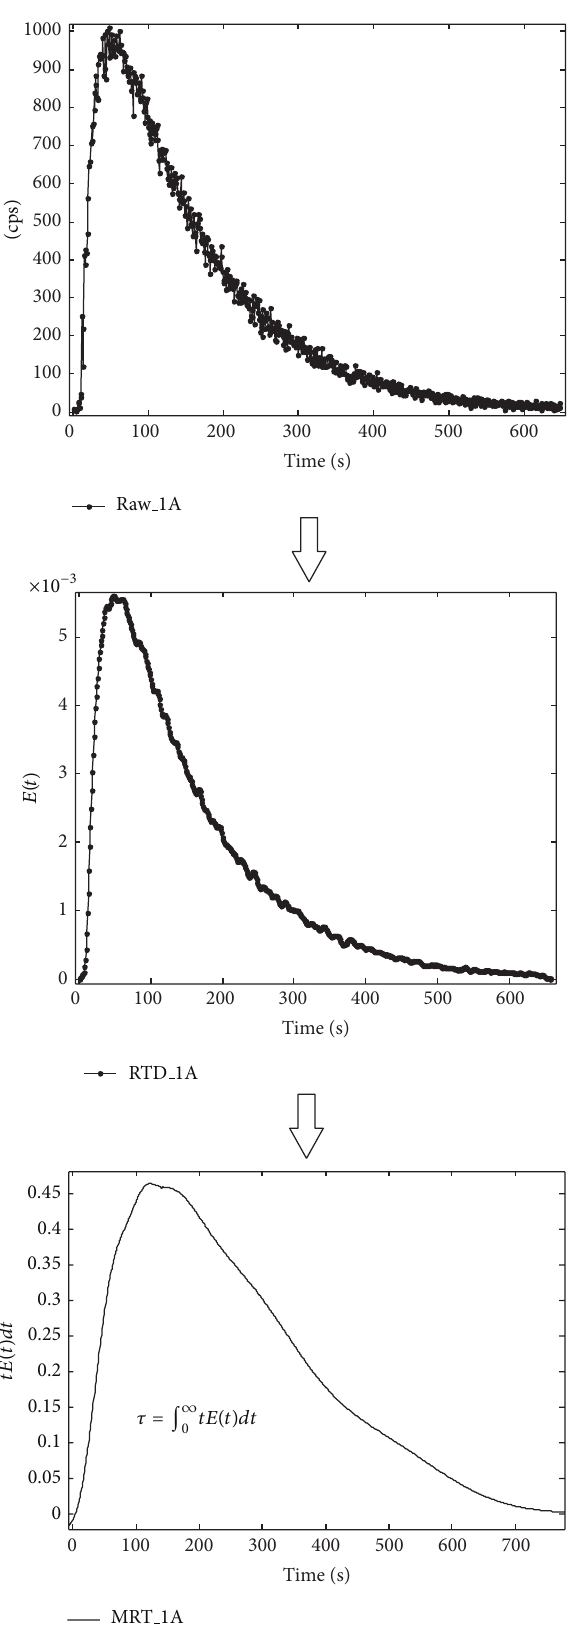
Figure 3: Determination of mean residence time